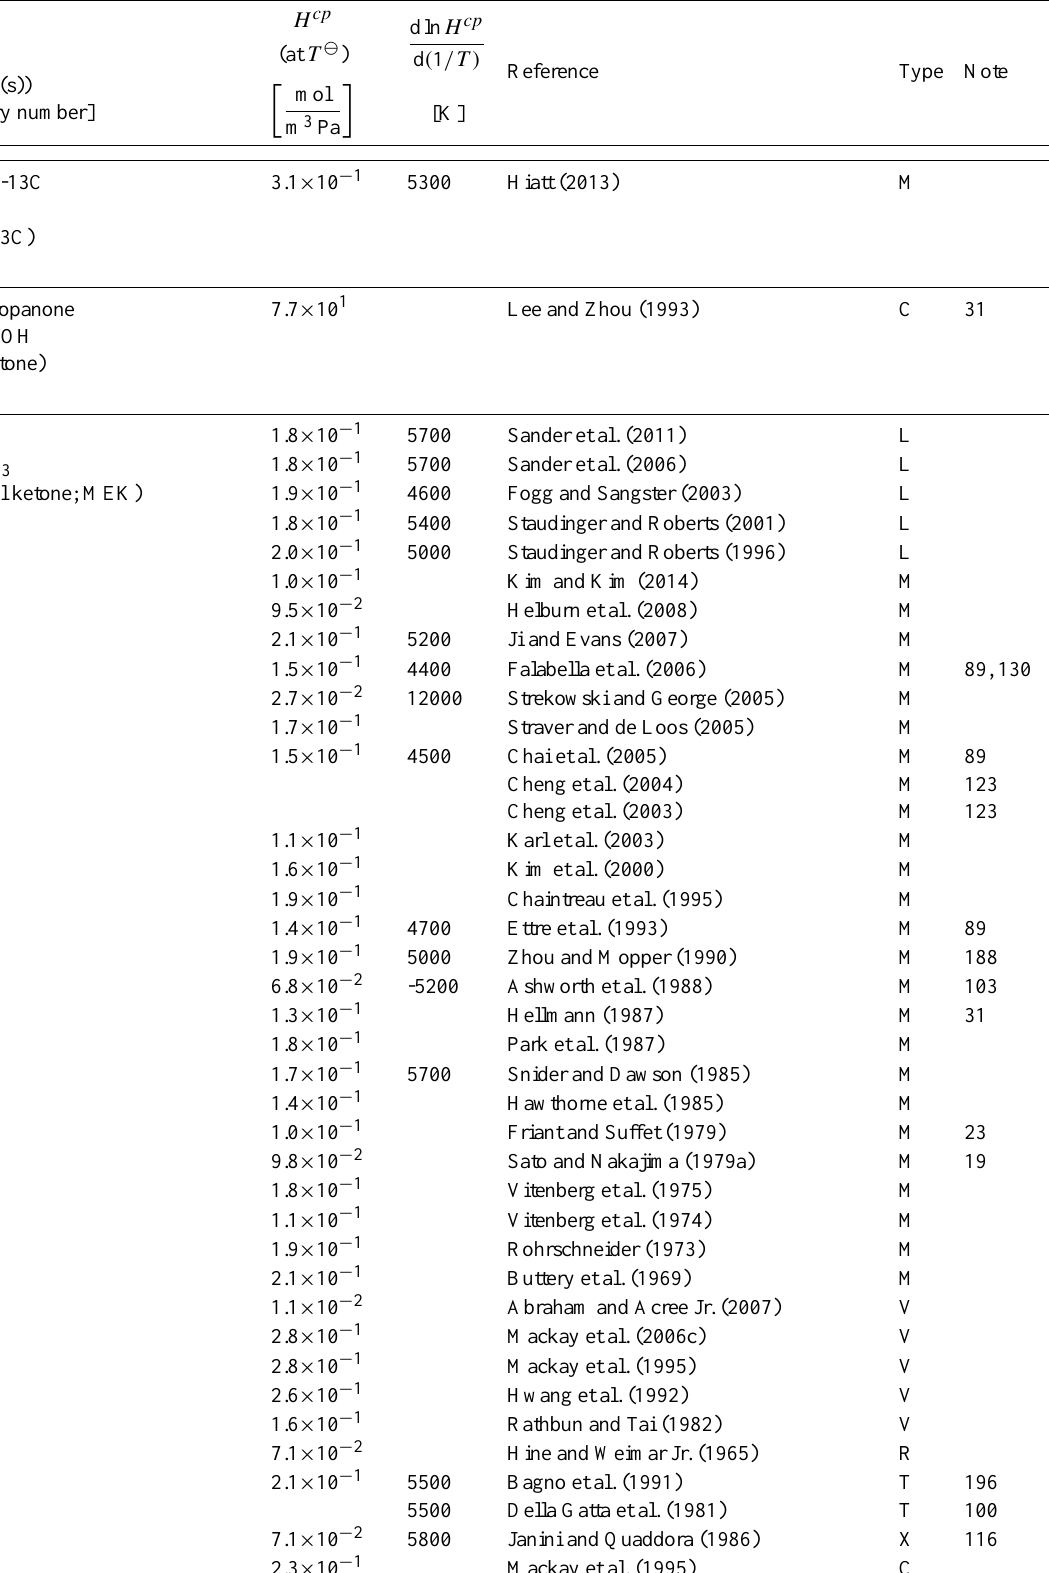
Table 6: Henry’s law constants for water as solvent